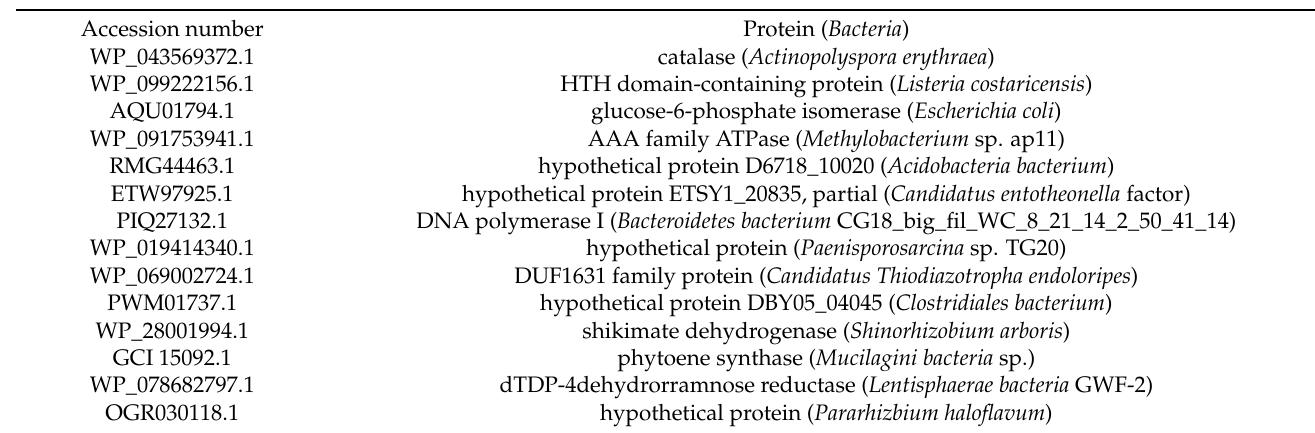
Figure 2. Bar graphs showing the comparison of proteins present in both the test group and the control group. Statistically significant results that remained significant after applying the Bonferroni correction are marked with a red square. Graph showing protein content comparisons for which emPAI values were: significantly higher in the study group compared to control ( A ); significantly higher in control compared to the study group ( B ); not significantly higher in the study group compared to the control (the results, however, trend toward significance) ( C ); not significantly higher in the study group compared to control ( D ); not significantly higher in control compared to study group ( E ). Expressions from Figure 2 are explained in Table 2. Table 2. Legend to Figure